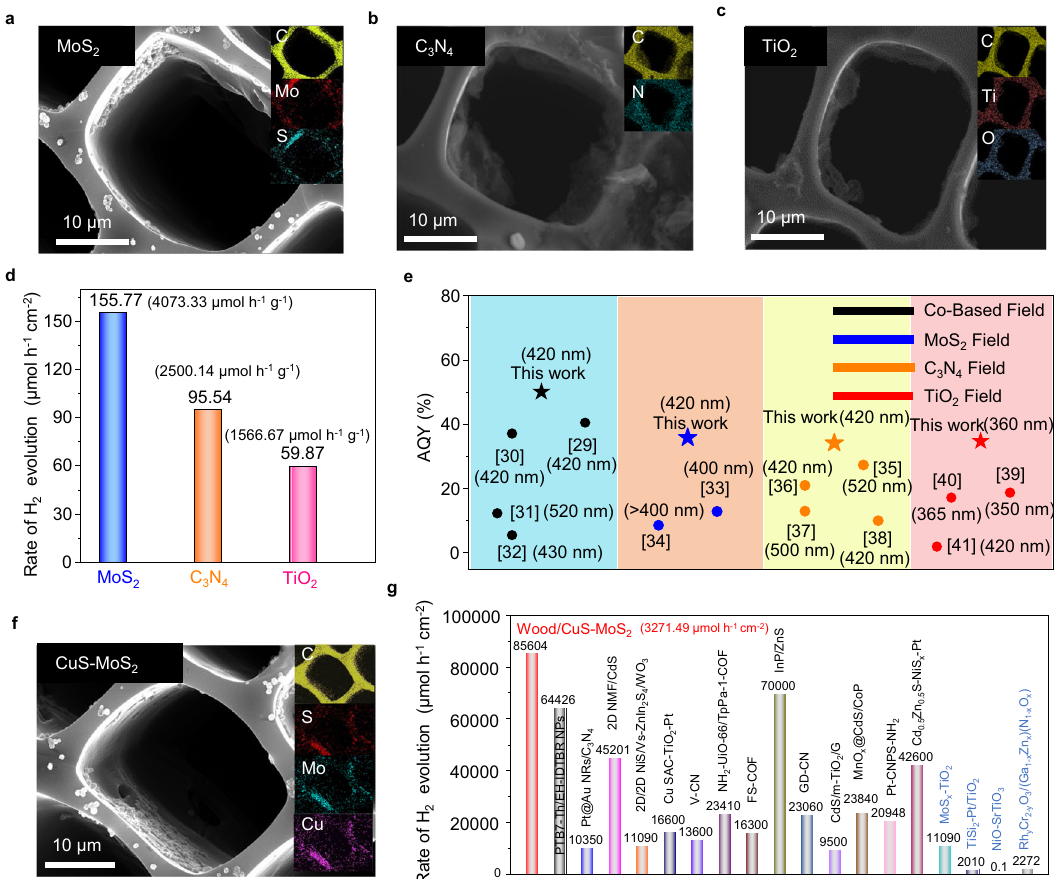
Fig. 5 The universal feature of the photothermal – photocatalytic biphase system for photocatalytic hydrogen evolution from water. a SEM images and EDS mapping of the wood/MoS 2 . b SEM images and EDS mapping of the wood/C 3 N 4 . c SEM images and EDS mapping of the wood/TiO 2 systems. d H 2 evolution rates of the wood/MoS 2 , wood/C 3 N 4 , and wood/TiO 2 systems. e Comparison of the AQY with literature in different particulate photocatalytic systems of TiO 2 , C 3 N 4 , MoS 2 , and Co-based photocatalysts, respectively. The numbers are the reference numbers and light wavelength. The maximum AQY data in literature and measurement results are presented for comparison. f SEM image and EDS mappings of the wood/CuS – MoS 2 photothermal – photocatalytic system. g Comparison of the H 2 evolution rate of different particulate photocatalytic systems reported to date. The blue fonts on the right represent the photocatalytic reaction in the gas-phase water environment. The light source is a solar simulator at AM 1.5 G illumination (100 mW cm − 2